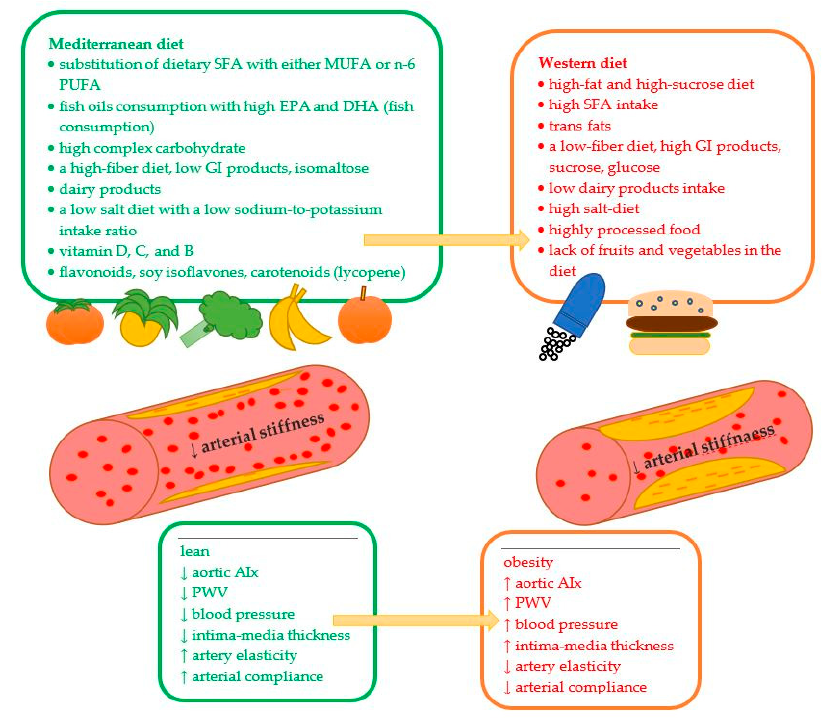
Figure 2. The influence of selective nutrients on arterial stiffness. ↓ —decrease; ↑ —increase; AIx—augmentation index; PWV—brachial-ankle pulse wave velocity; DHA—docosahexaenoic acid; EFA—essential fatty acids; EPA—eicosapentaenoic acid; GI—glycemic index; MUFA—monounsaturated fatty acids; PUFA—polyunsaturated fatty acids; SFA—saturated fatty acids.